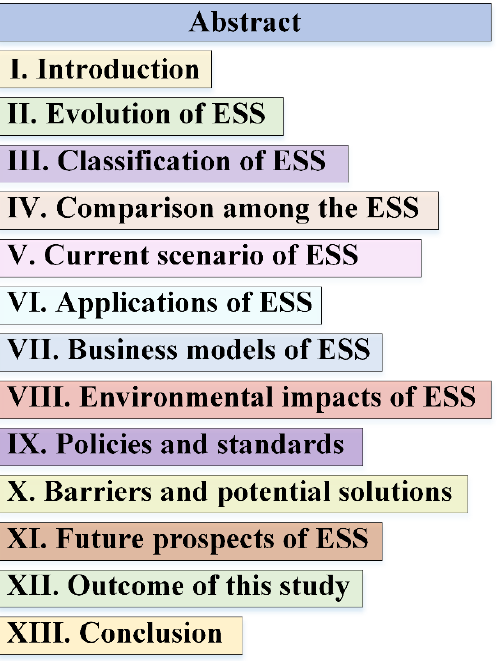
Figure 2. Information flow of this paper.